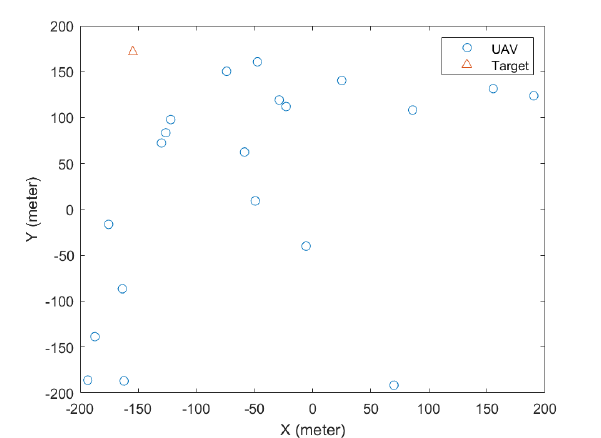
Figure 5. The simulation scenario of a single-fixed